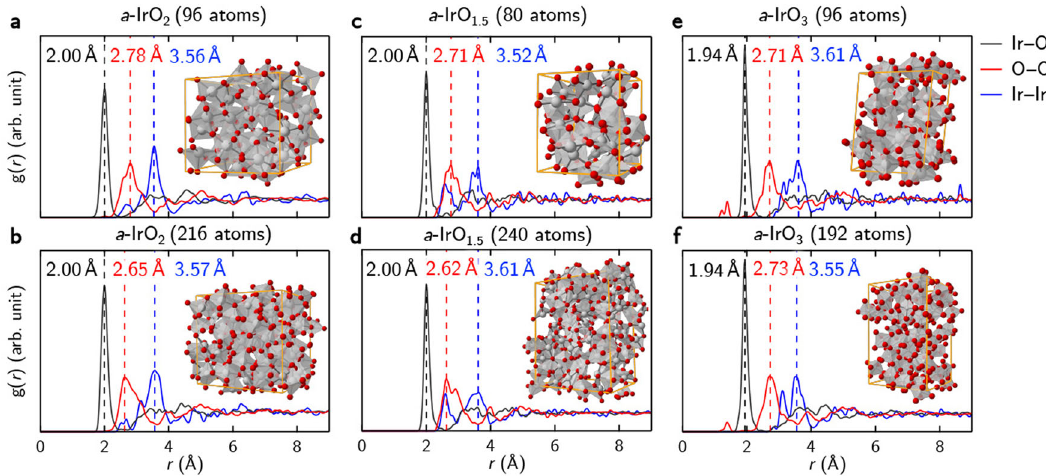
Fig. 2 Partial radial distribution function (RDF, g ( r )) for the amorphous phases. a , b IrO 2 , c , d IrO 1.5 . and e , f IrO 3 . The total number of atoms per simulation cell is shown for each case. The highest peak for the Ir – O, O – O, and Ir – Ir bond pair in the g ( r ) is denoted by a vertical black, red, and blue dotted line, respectively. The optimized atomic structure for each amorphous iridium oxide phase is also shown, where the gray and red spheres represent the iridium and oxygen atoms, respectively. The simulation cell is represented by the solid lines in orange.